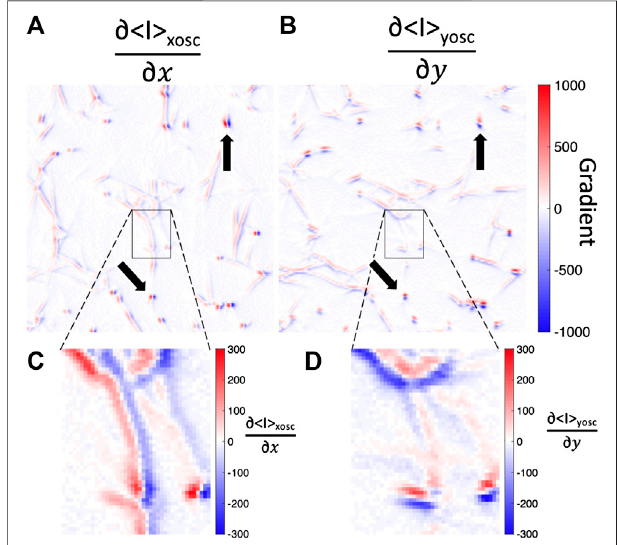
FIGURE 8 | Fluorescence image intensity gradients are steep across fi bers but not along fi bers. Spatial gradients in the (A) x -direction or (B) y -direction of the mean-intensity image while the bead is oscillated in the (A) x -direction ( 〈 I 〉 x ) or (B) y -direction ( 〈 I 〉 y ). Black arrows indicate some of the brightly fl uorescent points in the fi bers network which have steep intensity gradients in both directions. (C,D) Magni fi ed area showing a vertically aligned fi ber which has a distinct gradient across in the x -direction but a shallow gradient in the y